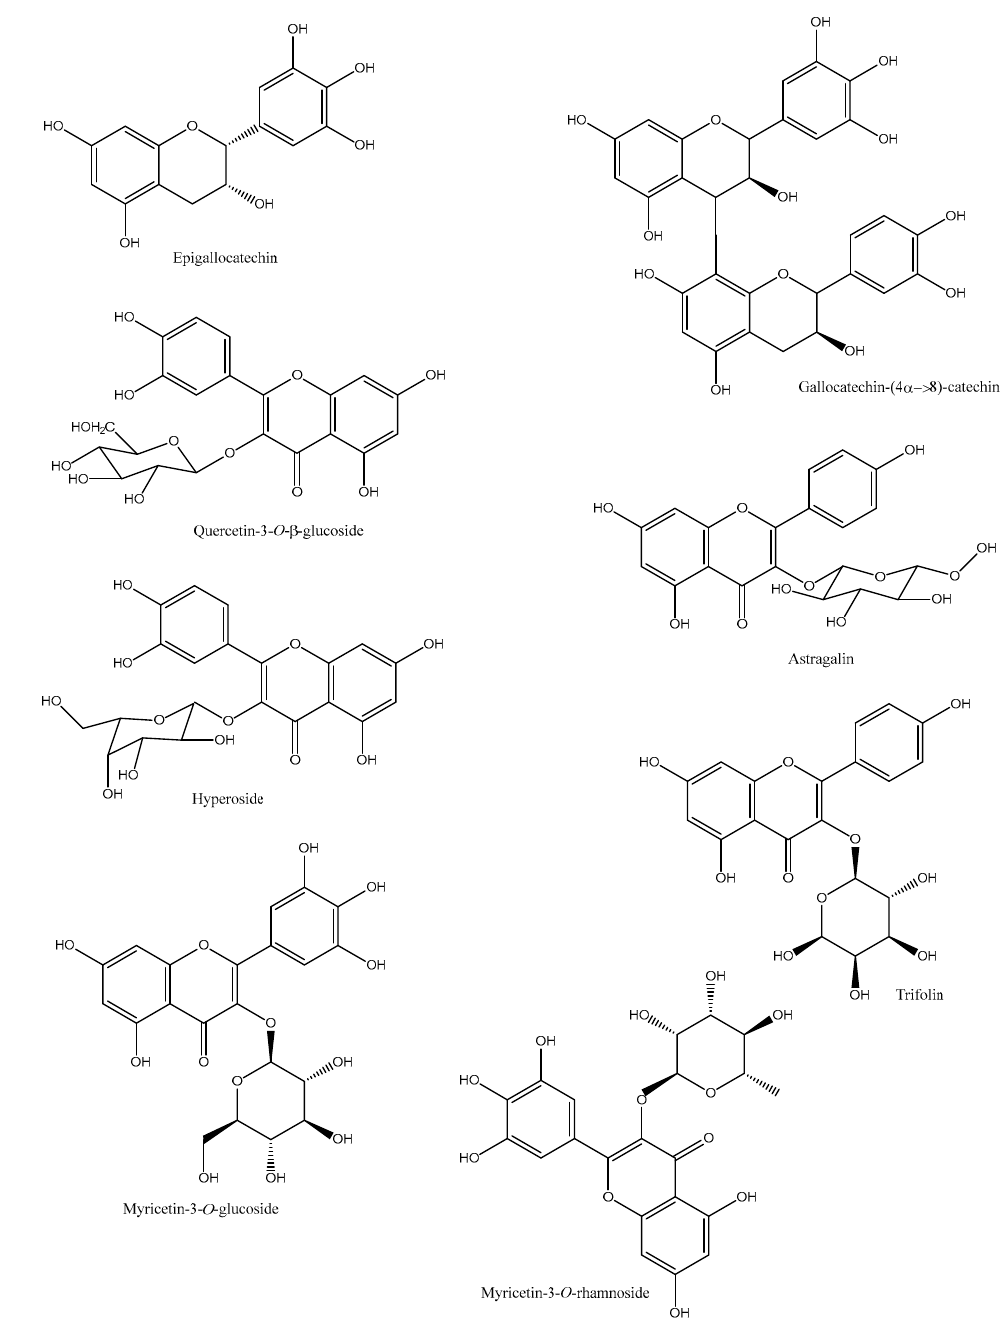
Figure 2. Major phenolic compounds found in